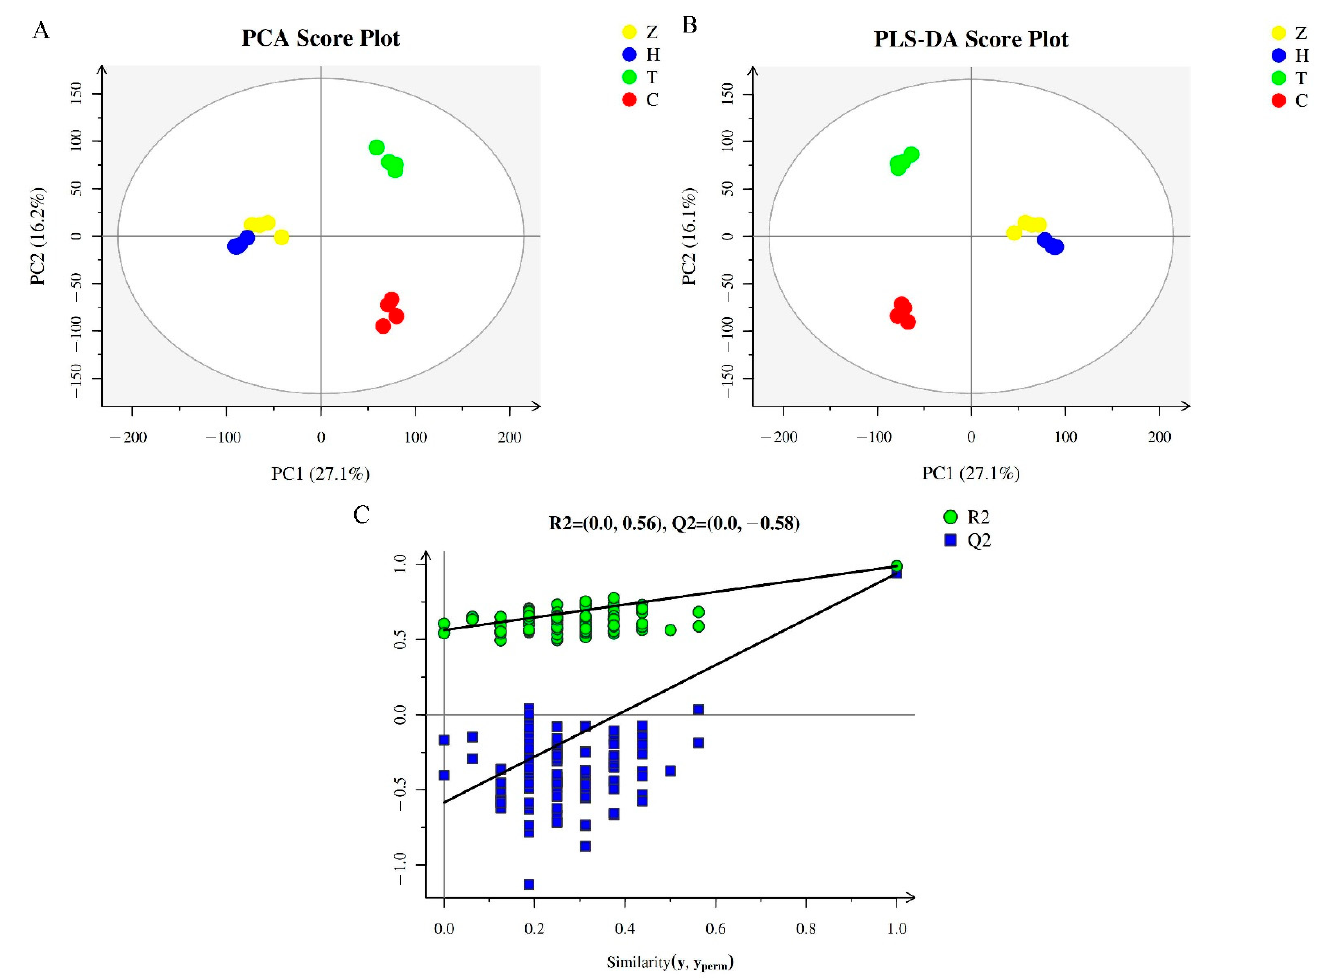
Figure 1. QC analysis results of metabolomics of different C. album cultivars. ( A ) PCA score plot for the 21,438 metabolites found in this study. ( B ) PLS-DA score and permutation test plots of the total 21,438 metabolites. ( C ) Displacement inspection result diagram. The yellow, blue, green, and red dots represent C. album cv. ‘Zilaiyuan’ (Z), ‘Huiyuan’ (H), ‘Tanxiang’ (T), and ‘Changying’ (C), respectively. The abscissa and ordinate represent the first and the second principal components, respectively.